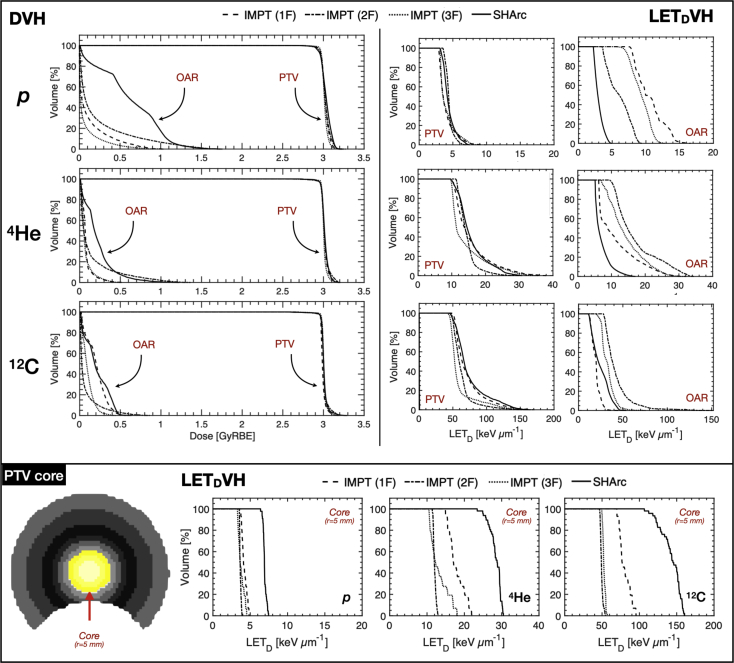
Dose volume histogram (DVH) (top left) and dose-averaged linear energy transfer volume histogram (LETDVH) (top right) for intensity modulated particle therapy (IMPT) (1F/2F/3F) versus spot-scanning hadron arc (SHArc) using p,4He, and 12C ions for case B with planning target volume (PTV), organs at risk (OAR), and normal tissue criteria/constraints. LETDVH for r = 5 mm PTV core is presented (bottom) with graphic highlighting considered volume. LET axes are scaled for relative comparison of each particle species.